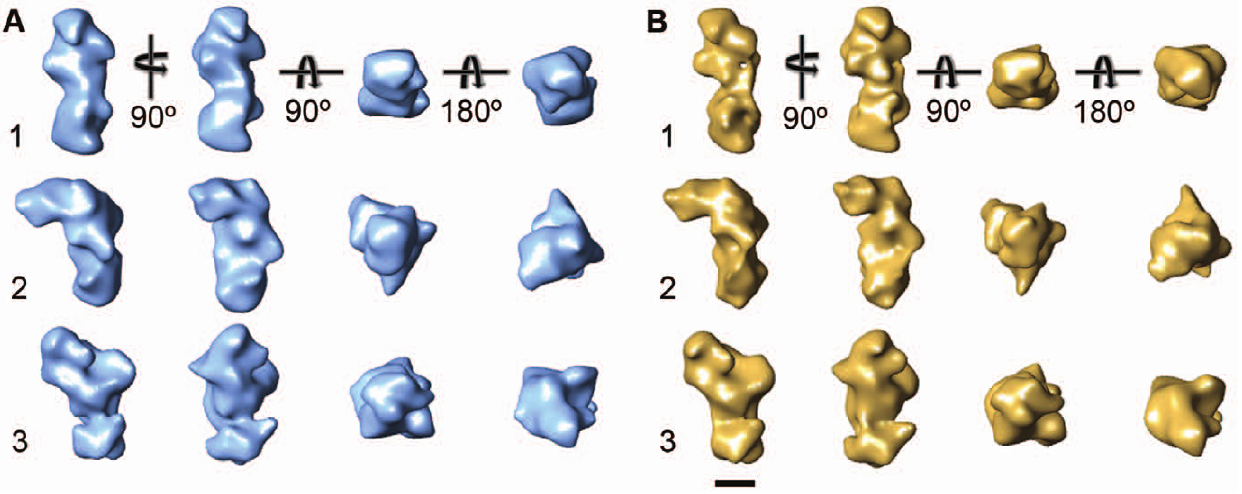
Figure 2. 3D reconstructions of the NECD. ( A ) Density maps of the Drosophila NECD corresponding to the averages shown in (B). ( B ) Corresponding density maps of the human NECD. Scale bar is 5 nm.